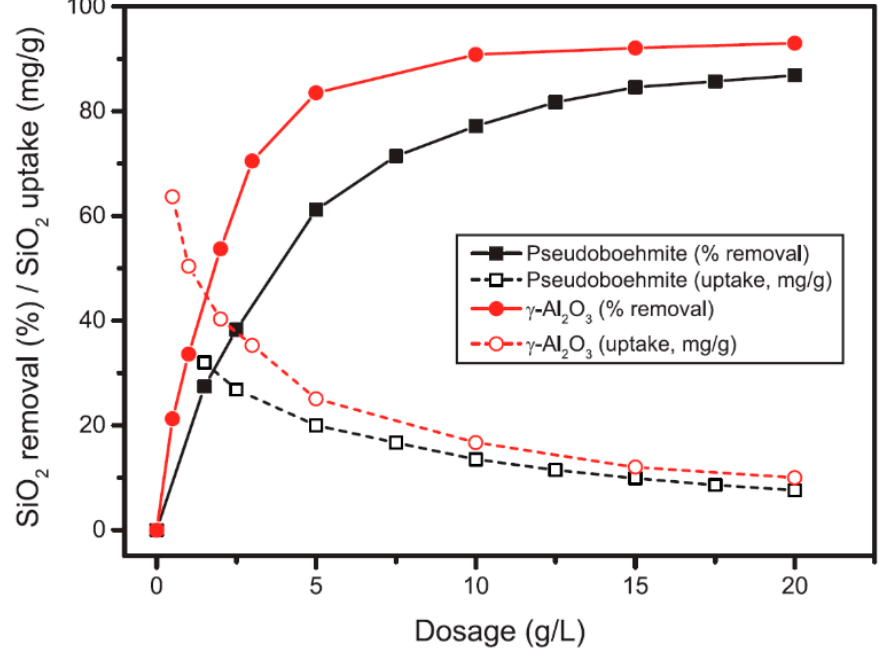
Figure 3. Silica removal vs. sorbent dosage (initial pH = 8.5, 20 °C, 4 h contact